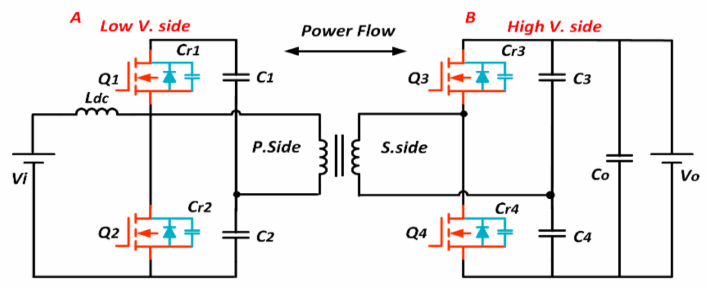
Figure 11. Isolated DHB bidirectional DC-DC converter [31].